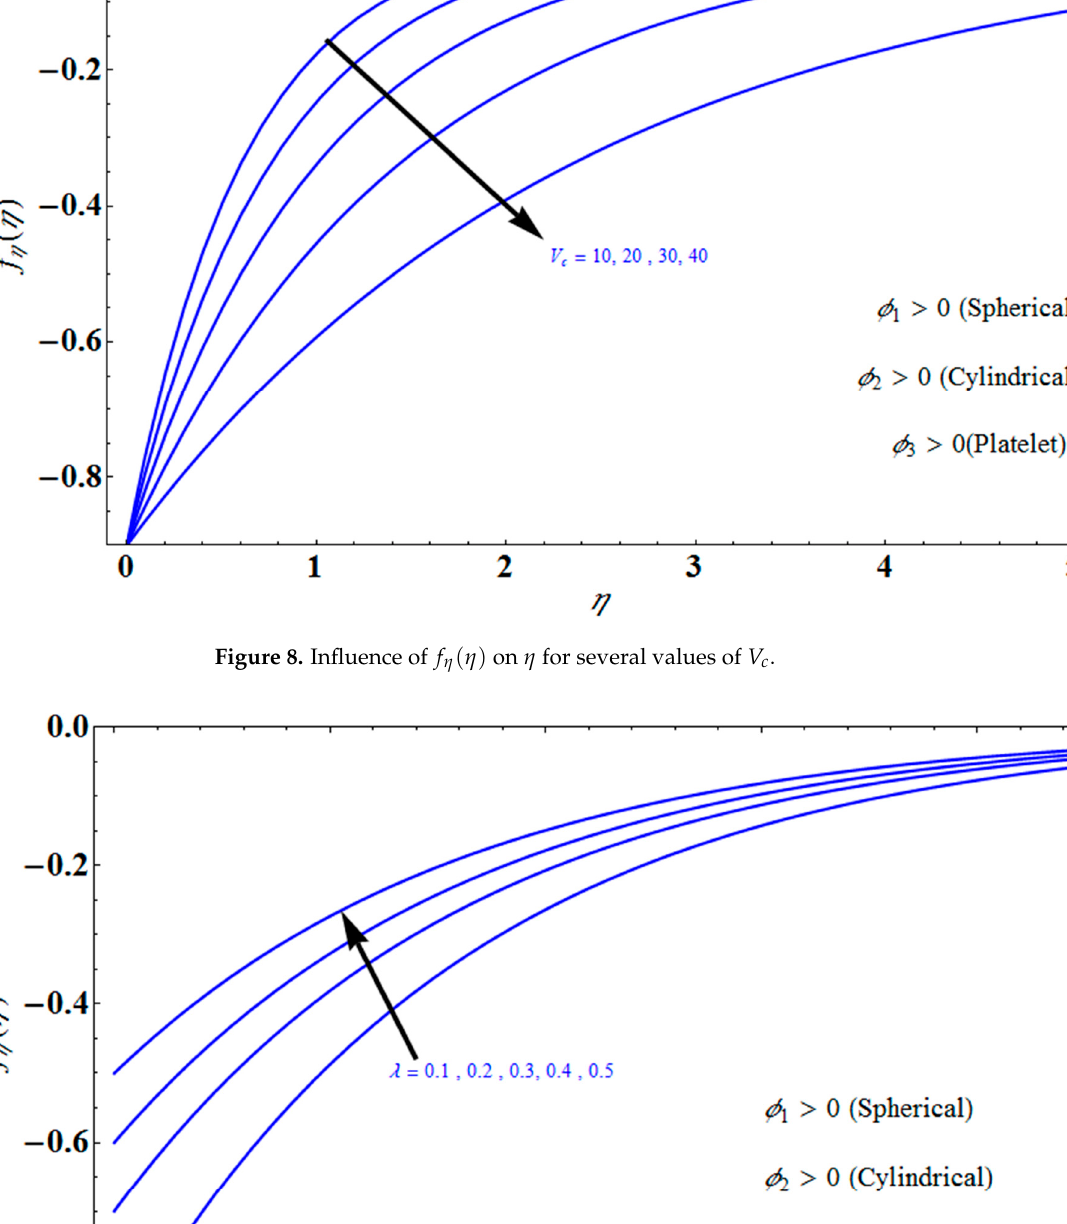
( ) ( ) η η η η f f on for different values of on for different values of η η